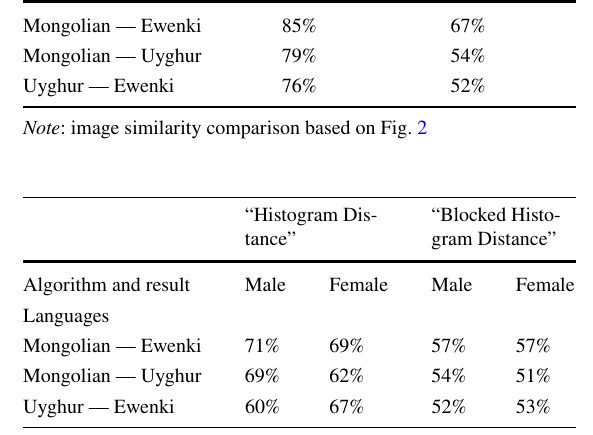
Note : image similarity comparison based on Fig.